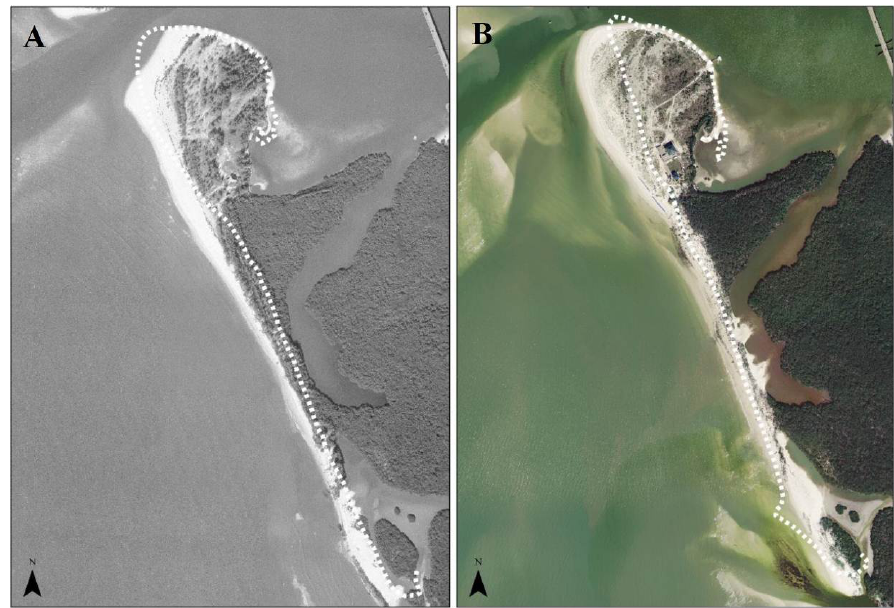
Figure 5. Morphologic changes of Big Hickory Island. ( A ) 1996 aerial photograph with the approximate 2005 shoreline shown as a white dashed line; ( B ) 2005 aerial photograph with the approximate 2012 shoreline shown as a white dashed line.